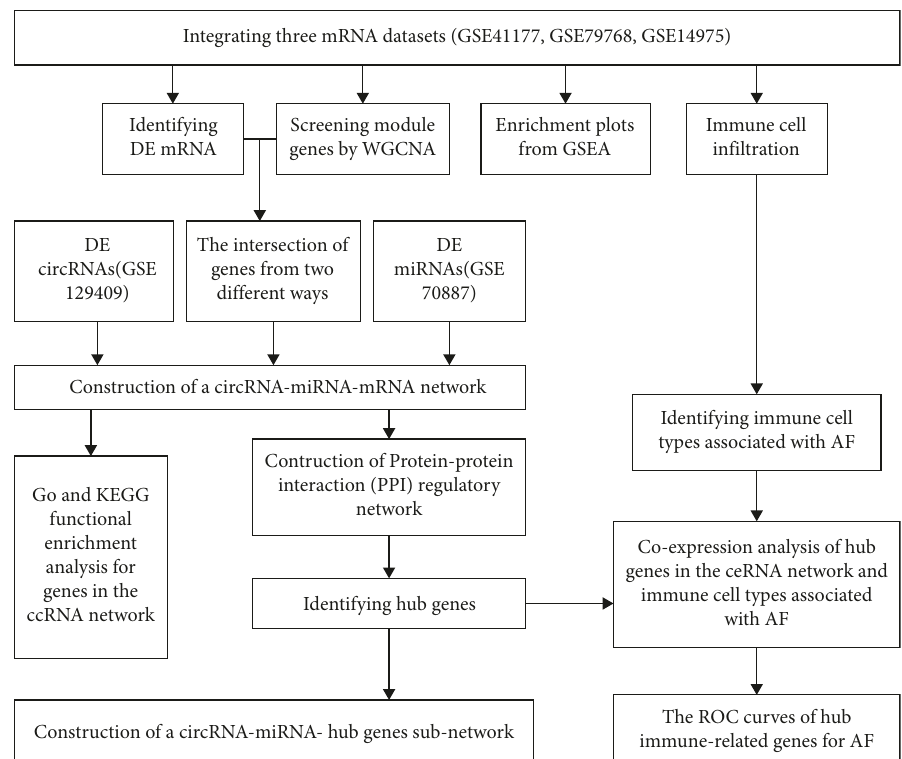
Figure 1: Flow diagram of bioinformatics